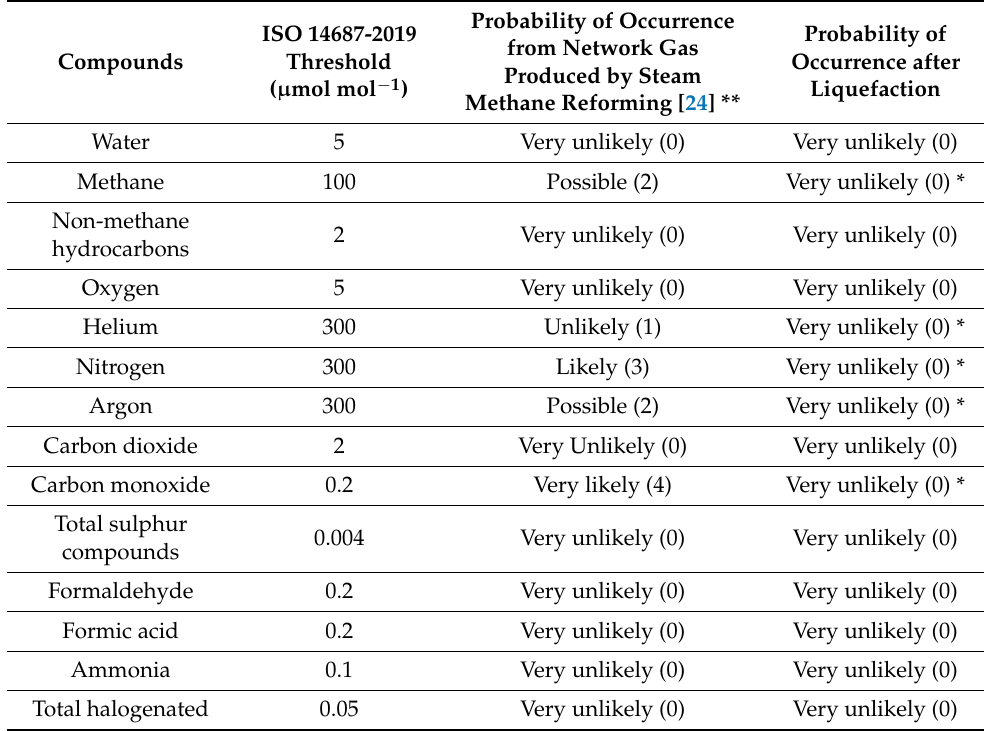
Table 3. Impact of the liquefaction on the contaminant occurrence.